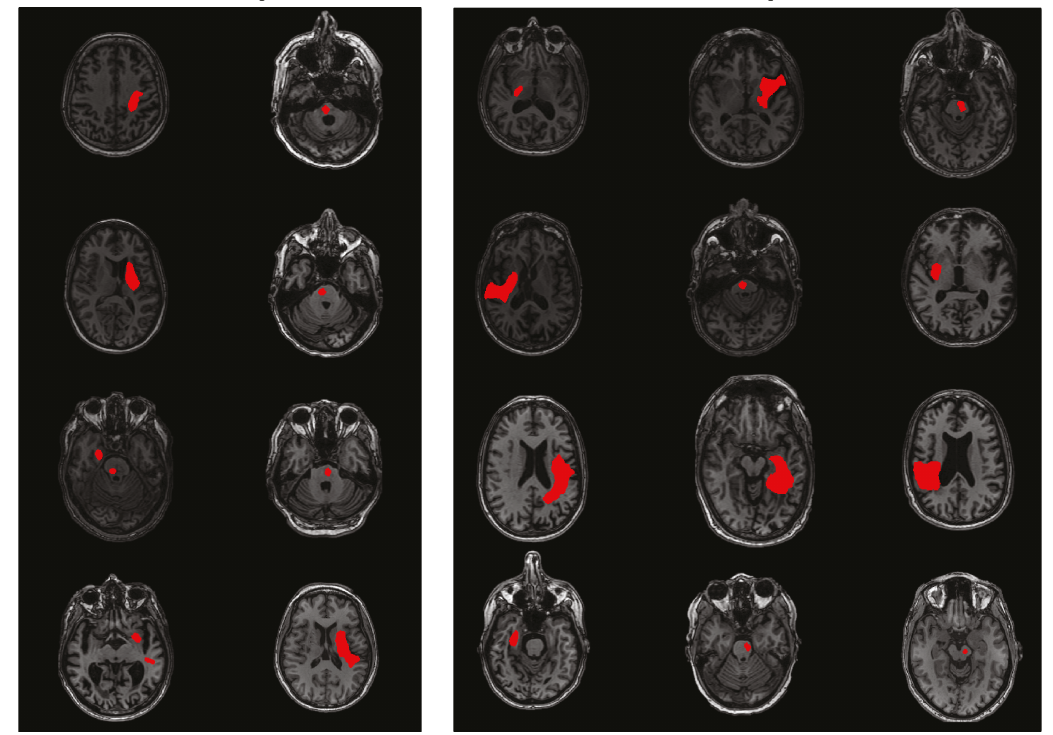
Figure 4: Lesion fi gure for M1c and S1c (sensorimotor- [SM]-) cTBS motor practice responders versus